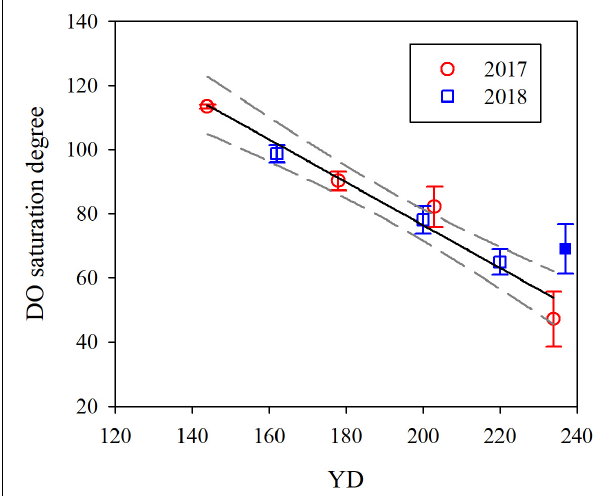
FIGURE 5 | Temporal evolution of the mean DO saturation degree in bottom water. YD stands for day of the year. Error bars are 1 standard deviation. The solid and dashed lines are the linear fit to the data and 95% confidence interval, respectively. The solid blue point was excluded for data fitting. The regressed equation is: Y = (-0.67 ± 0.06) X + (210.0 ± 12.0), R 2 = 0.96, p =